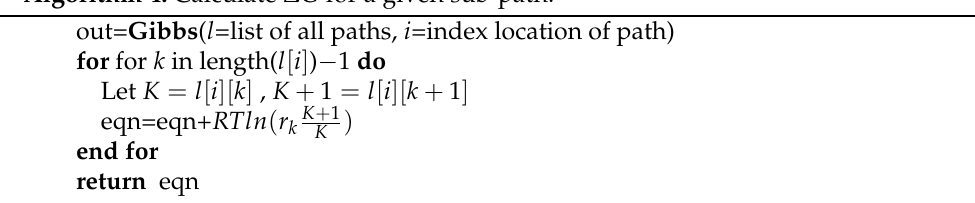
Algorithm 4: Calculate ¯ ∆ G for a given